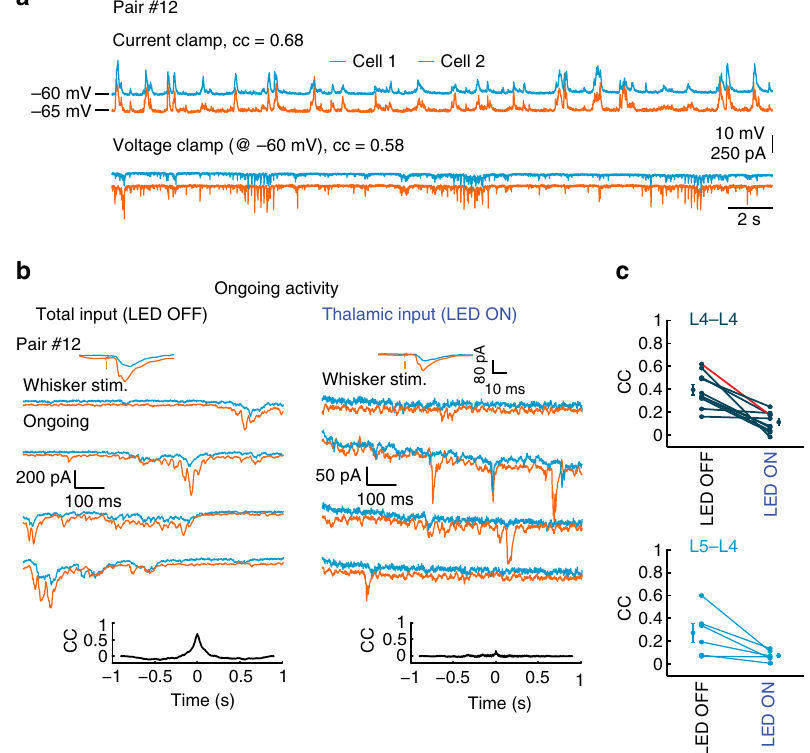
Figure 3 | Isolated thalamic inputs exhibit weak correlation during ongoing activity. ( a ) Simultaneous whole cell recordings of two putative excitatory L4 cells during ongoing activity in current clamp and voltage clamp (at the reversal potential of inhibition) modes recorded in anaesthetized mouse. ( b ) Example traces of ongoing excitatory currents in two simultaneously recorded L4 cells during LED OFF and LED ON conditions. Upper insets, average excitatory responses to whisker stimulation. Lower insets, cross-correlation between the cells. ( c ) Population CC values for L4–L4 pairs n ¼ 10, P ¼ 0.002, Wilcoxon signed-rank test) and L4–L5 pairs n ¼ 6, P ¼ 0.0313, Wilcoxon signed-rank test). Example pair in b is depicted in population mean CC ¼ 0.11 ± 0.02, Fig. 3c, upper panel, LED ON, signed-rank test). The synaptic activity during LED ON decreased z ¼ (cid:2) 2.8031, P ¼ 0.002, Wilcoxon signed-rank test). We by 33 ± 4.5% ( P ¼ 6e (cid:2) 6 , Wilcoxon signed-rank test, measured from the total excitatory charge Q , the time integral of the EPSCs) extended our database by recording from mixed pairs, where and in an equivalent manner in both cells (Supplementary Fig. 5 one cell was located in L4 and the other in L5 (Supplementary in each pair), indicating that reduced CC was not due shows Q LEDon Fig. 4). Similar to L4–L4 pairs, CC of excitatory synaptic currents Q LEDoff to unequal light effects. Hence, synchronized ongoing activity in in L4–L5 pairs during ongoing activity (mean CC ¼ 0.27 ± 0.08, cortical neurons, within and across different thalamic recipient n ¼ 6 pairs, Fig. 3c, lower panel, LED OFF) dropped significantly layers, depends on recurrent cortical activity and does not reflect when cortical firing was silenced (mean CC ¼ 0.07 ± 0.02, the correlation between the cell’s feedforward thalamic inputs. Fig. 3c, lower panel, LED ON, z ¼ (cid:2) 1.862, P ¼ 0.0313, Wilcoxon